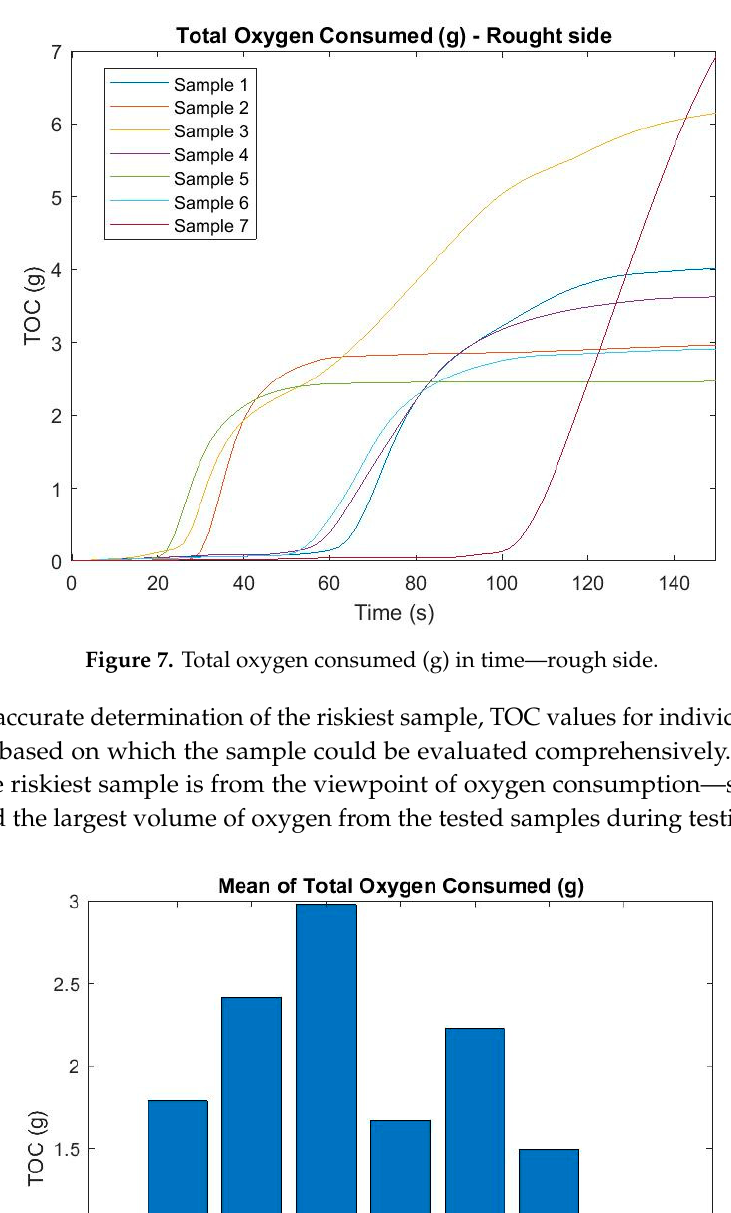
Figure 7. Total oxygen consumed (g) in time—rough side.